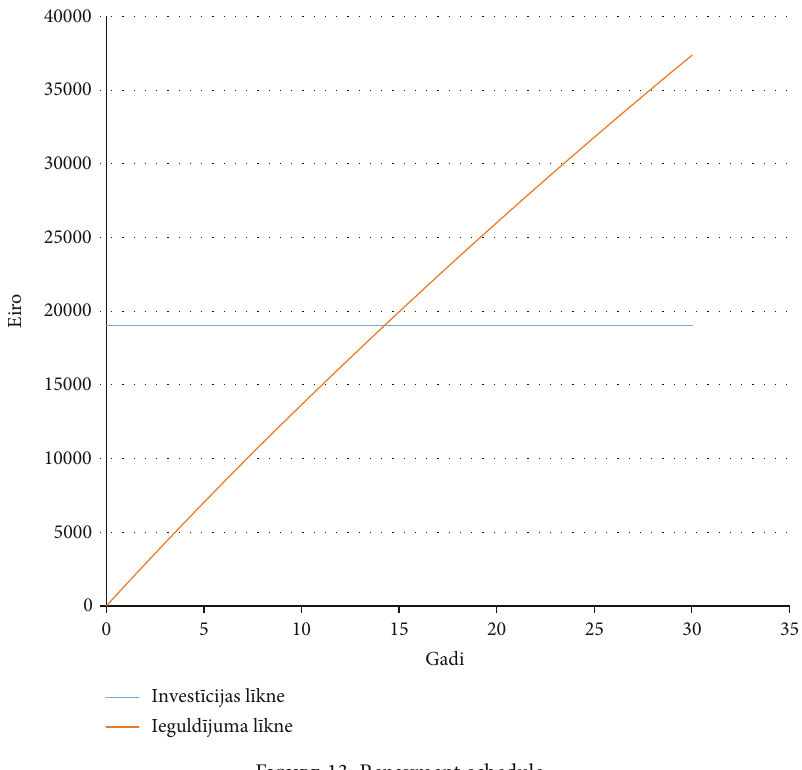
Figure 13: Repayment schedule.